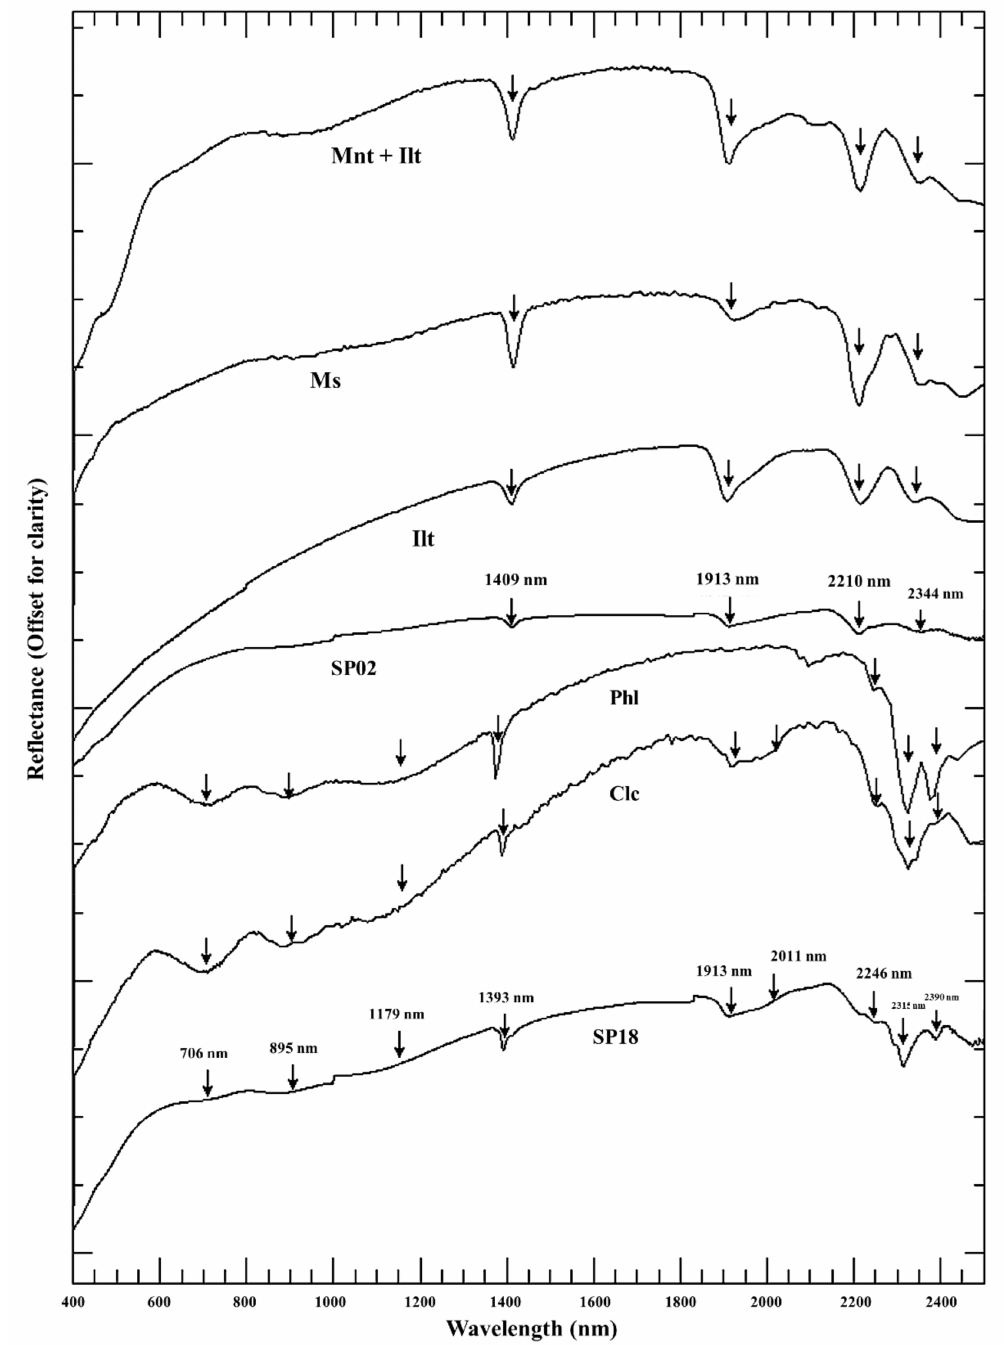
Figure 3. SP02 and SP18 spectra stacked with reference spectra of clinochlore (Clc), phlogopite (Phl), illite (Ilt), muscovite (Ms), and montmorillonite